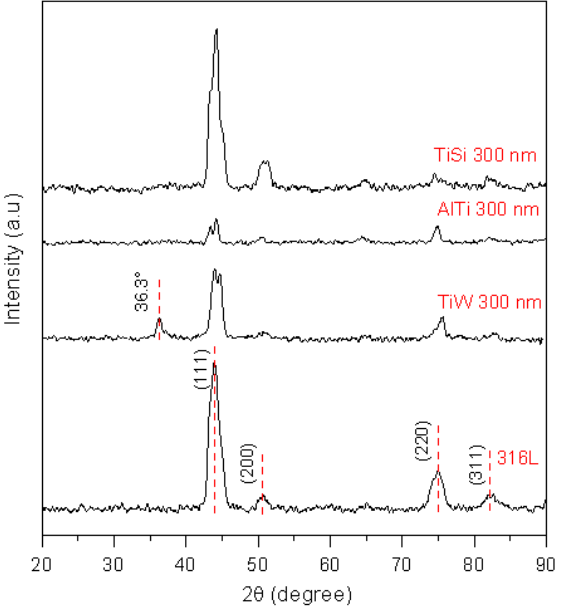
Figure 3. X-ray diffraction of the TiSi, AlTi, and WTi coatings and the 316L stainless steel substrate. Table 2. Results of microhardness and roughness of TiSi, AlTi, and WTi coatings.